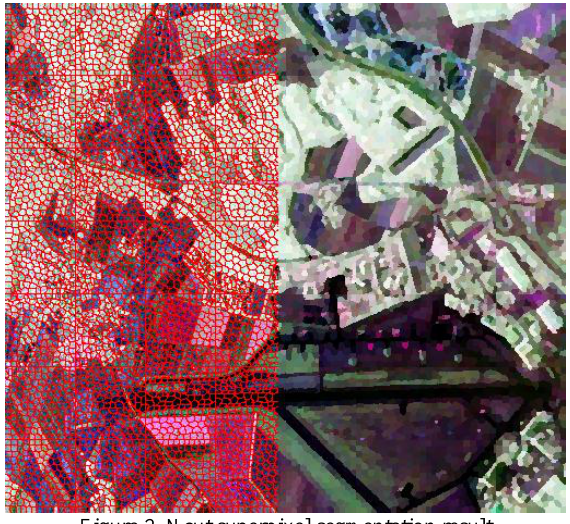
Figure 2. Ncut superpixel segmentation result